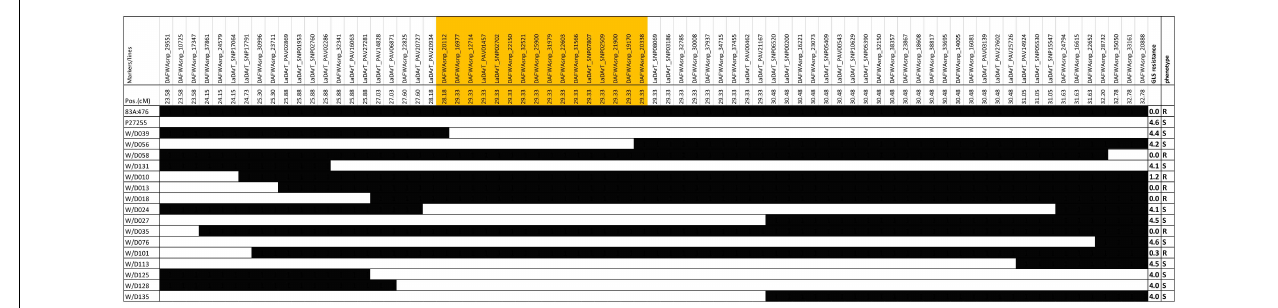
FIGURE 4 | Recombinant lines for fine-mapping of gray leaf spot resistance.